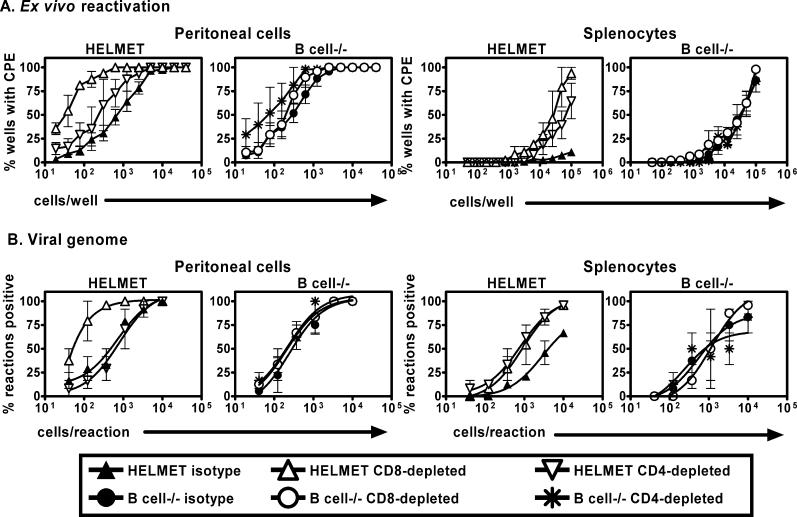
CD8 T Cells Induced by the Presence of HEL-Specific B Cells Are Essential for Control of γHV68 Latency(A) Effects of CD8- and CD4-depletion on the frequency of cells reactivating ex vivo from latency in peritoneal cells (left two graphs) and splenocytes (right two graphs) 42 d after infection in HELMET and B cell−/− mice.(B) Effects of CD8- and CD4-depletion on the frequency of cells carrying viral genome in peritoneal cells and splenocytes 42 d after infection. These data were pooled from two to three independent experiments using three to five mice per experiment.